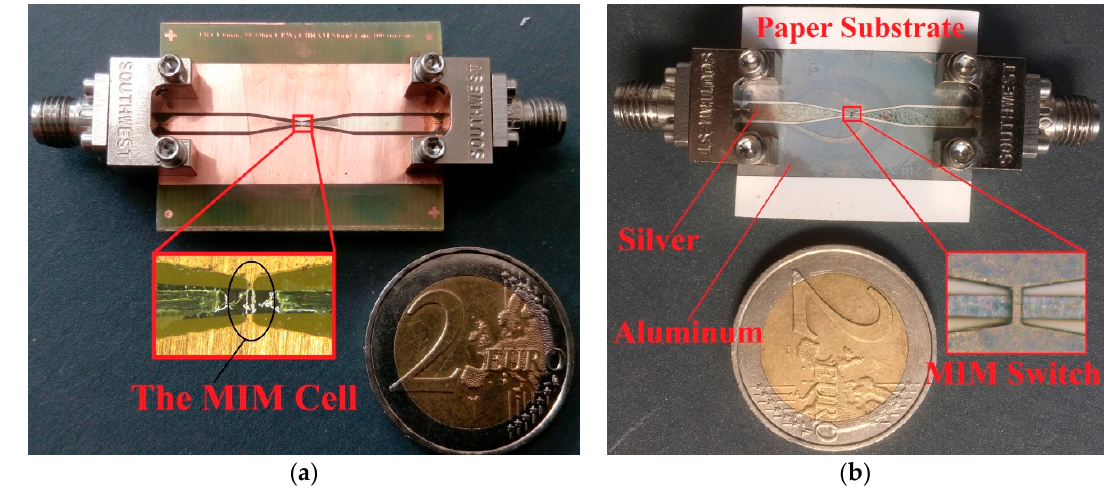
Figure 4. Photographs of the fabricated RF-switch on classic FR-4 substrate ( a ), and on paper substrate ( b ). Inset of both photographs shows the microphotograph of the MIM switch area.